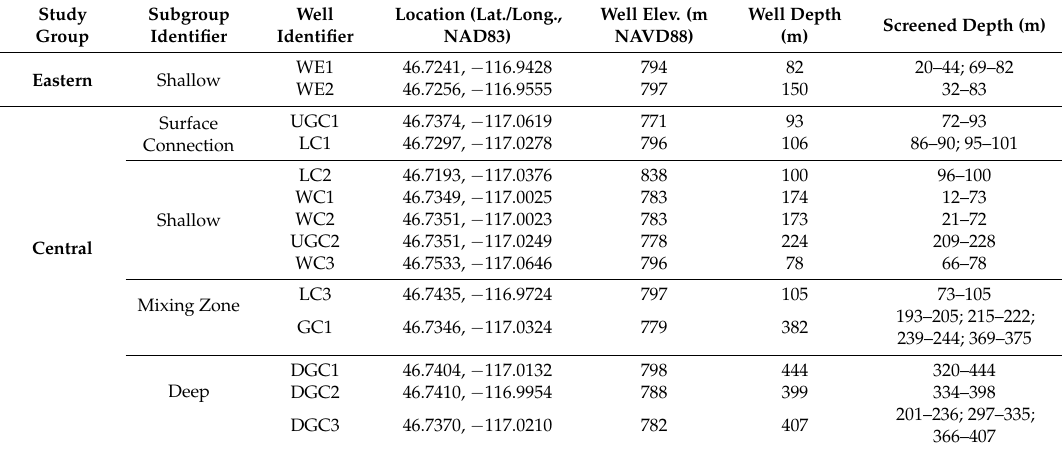
Table 1. Descriptions of wells east of Moscow (Eastern) and wells in and near Moscow (Central), Idaho, sampled as part of this study (Figure 1). Subgroup identifiers relate to likely source waters and depth. Well identifiers are based on formation and depth of screen interval(s) as determined from the geologic layer model (W = Wanapum, G = Grande Ronde, UG = Upper Grande Ronde, DG = Deep Grande Ronde, L = Latah Formation) and location (E = Eastern, C = Central).